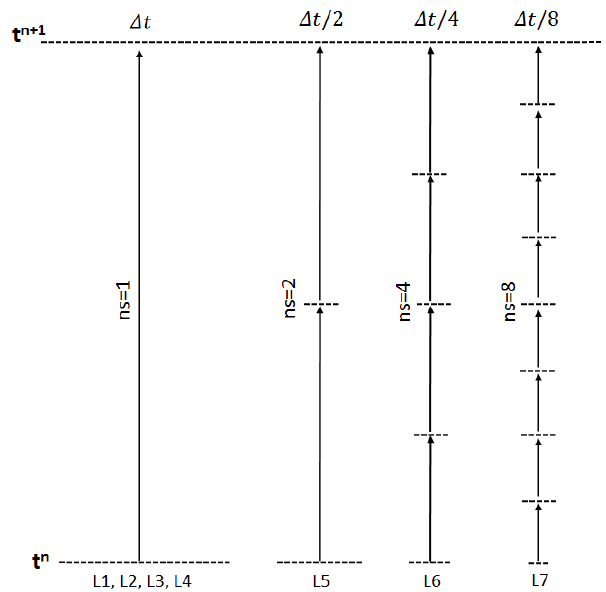
Figure 14. Illustration of the subcycling process for each level.